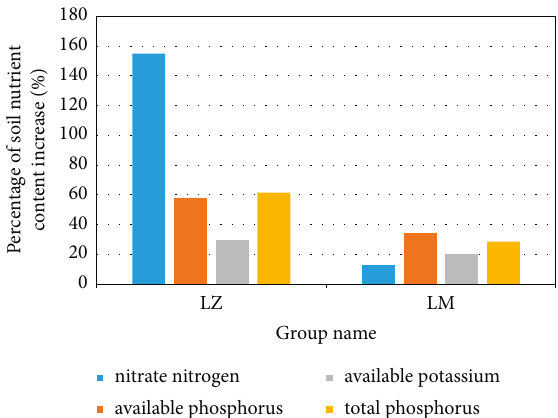
Figure 9: Fertility level of different treatment plans for green manure